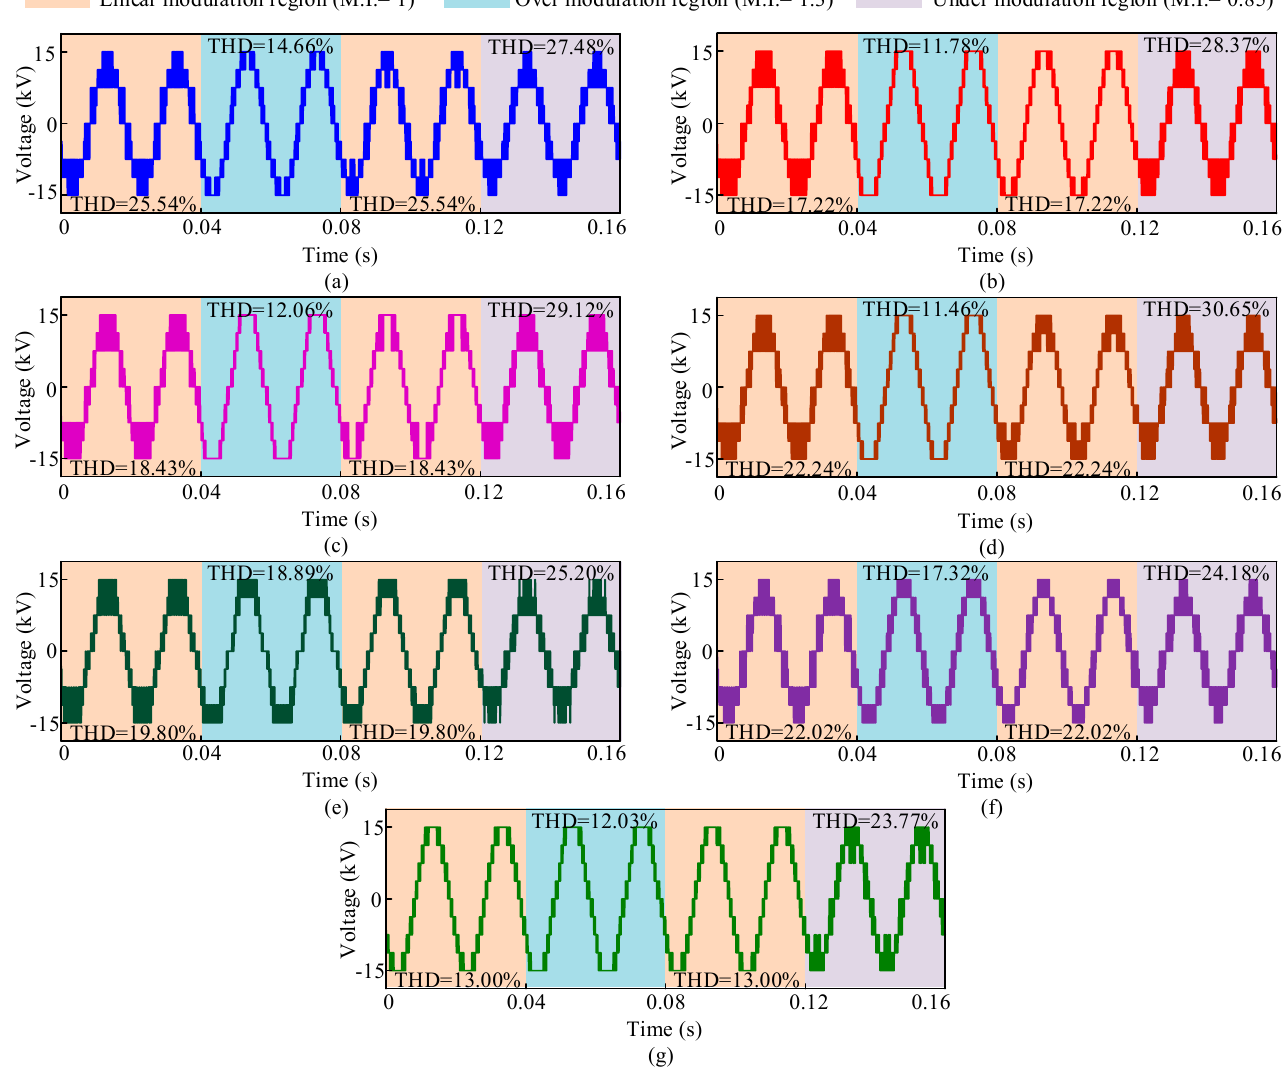
Figure 13. Converter output voltage profiles with the variation of modulation region for different PWM schemes: ( a ) SPWM, ( b ) THPWM, ( c ) CSVPWM, ( d ) THSDPWM, ( e ) TDBCPWM, ( f ) SDBCPWM, and ( g ) proposed TSCMPWM.